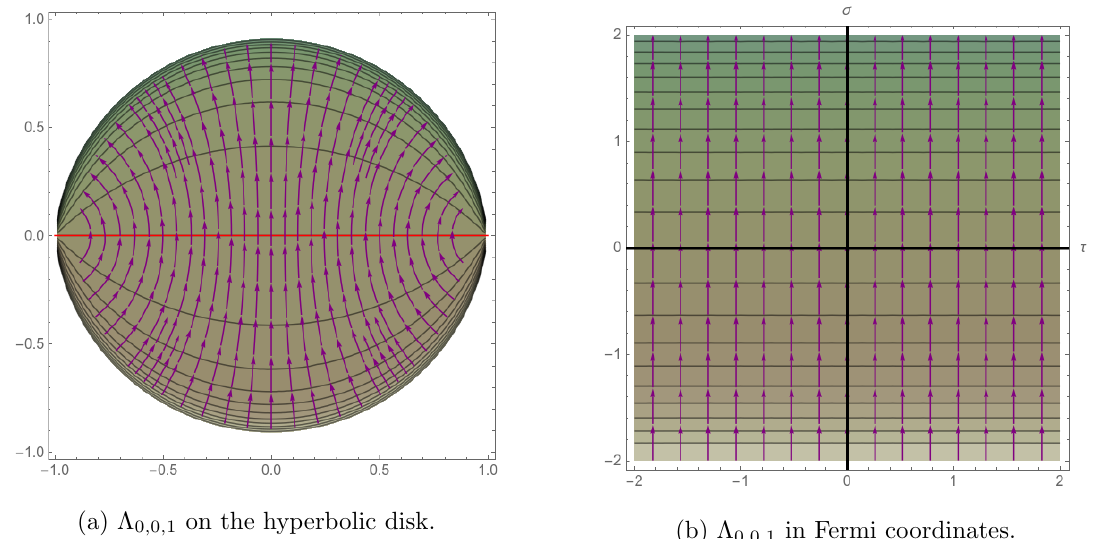
Figure 8. Contour plot of the canonical spacelike Hesse function (cid:3) 0 ; 0 ; 1 and of its gradient (cid:13)ow. The values of the function decrease from lightest brown to darkest green. The (cid:12)gure to the left is (cid:12)gure 5 recalled here for convenience of the reader. The vanishing locus of the function is the horizontal segment shown in red. The gradient vector (cid:12)eld is shown in purple. The (cid:12)gure to the right shows only a portion of the ( (cid:28); (cid:27)